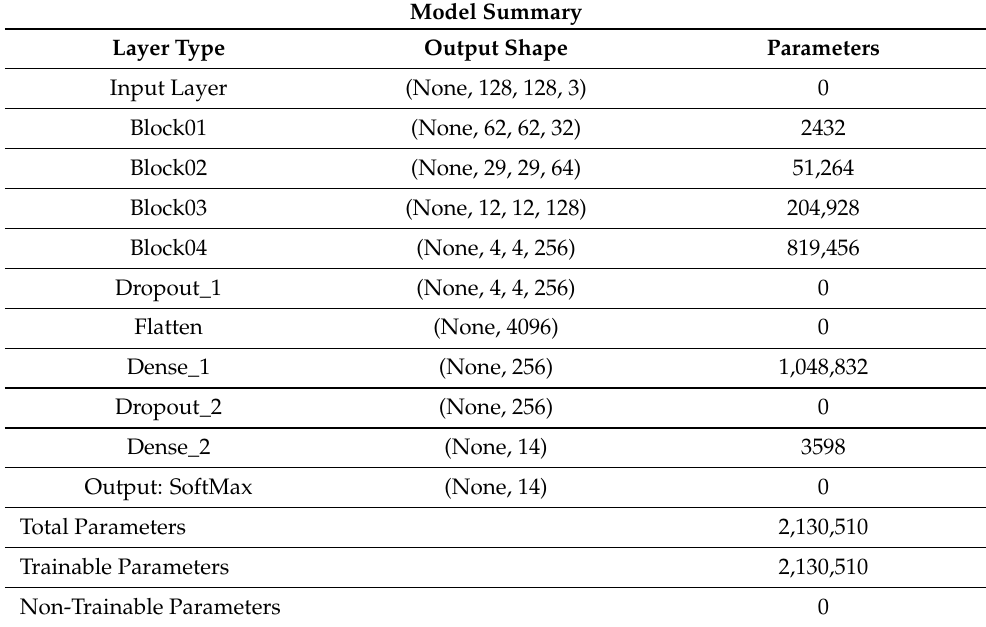
Table 4. List of total parameters used in proposed CNN